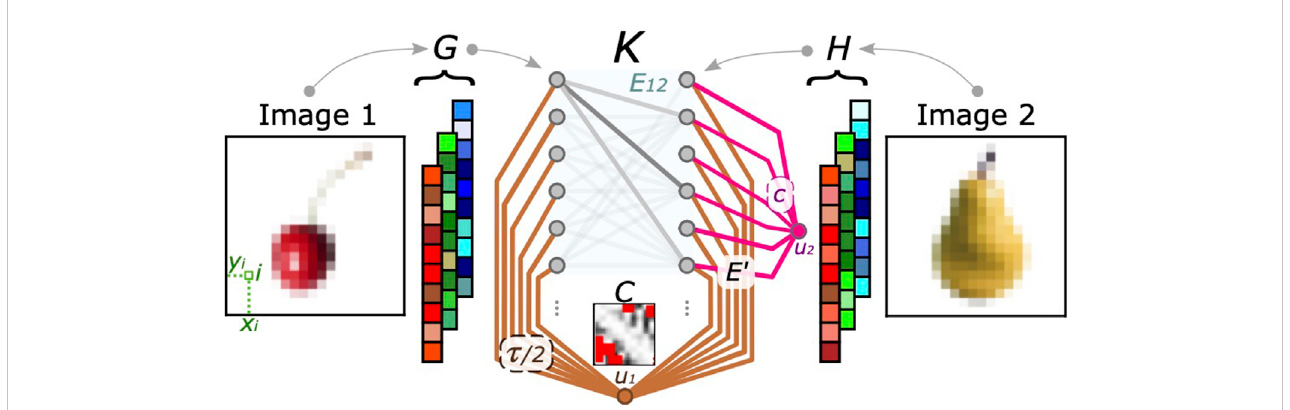
FIGURE 1 Bipartite network representation for multicommodity OT. The two images (shown on the leftmost and rightmost sides of the panel) are encoded in the RGB matrices G and H , which regulate the fl ow traveling on the network K . The graph is made of m + n + 2 nodes, i.e., the total number of pixels plus the two auxiliary vertices introduced in Section 3.1. Gray edges (belonging to the set E 12 ) connect nodes in image 1 to nodes in image 2; these edges are trimmed according to a threshold τ . We highlight the entries of the matrix C in red if these are larger than τ . Transshipment and auxiliary edges used to relax mass conservation (which belong to E ′ ) are colored in brown and